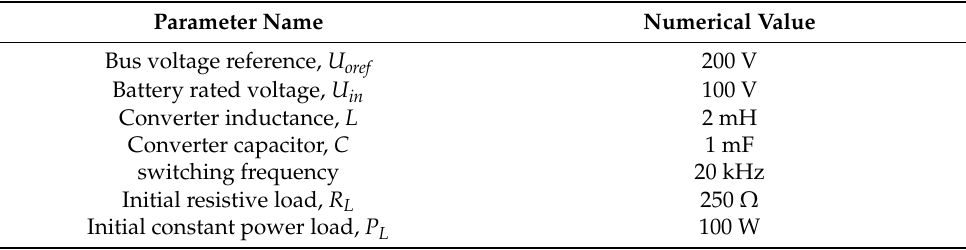
Table 1. DC microgrid circuit